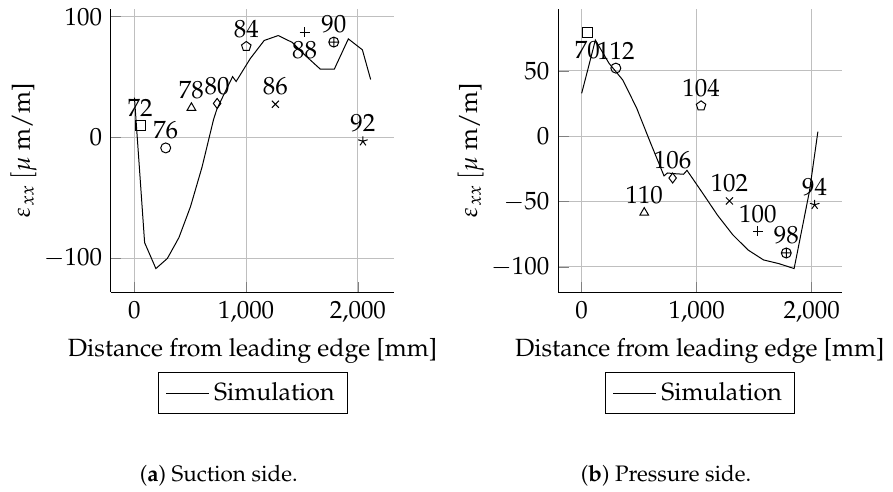
Figure A60. Strain comparison ε LL at radial position R = 8000mm for torsion load case LC_2.